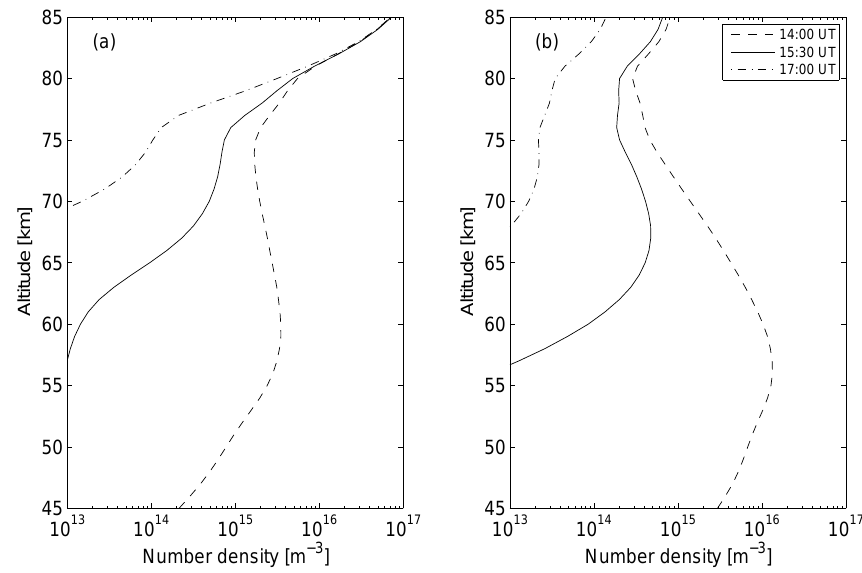
Fig. 12. Modelled concentration profiles of (a) atomic oxygen and (b) O 2 ( 1 1 g ) before, during, and after the sunset of 23